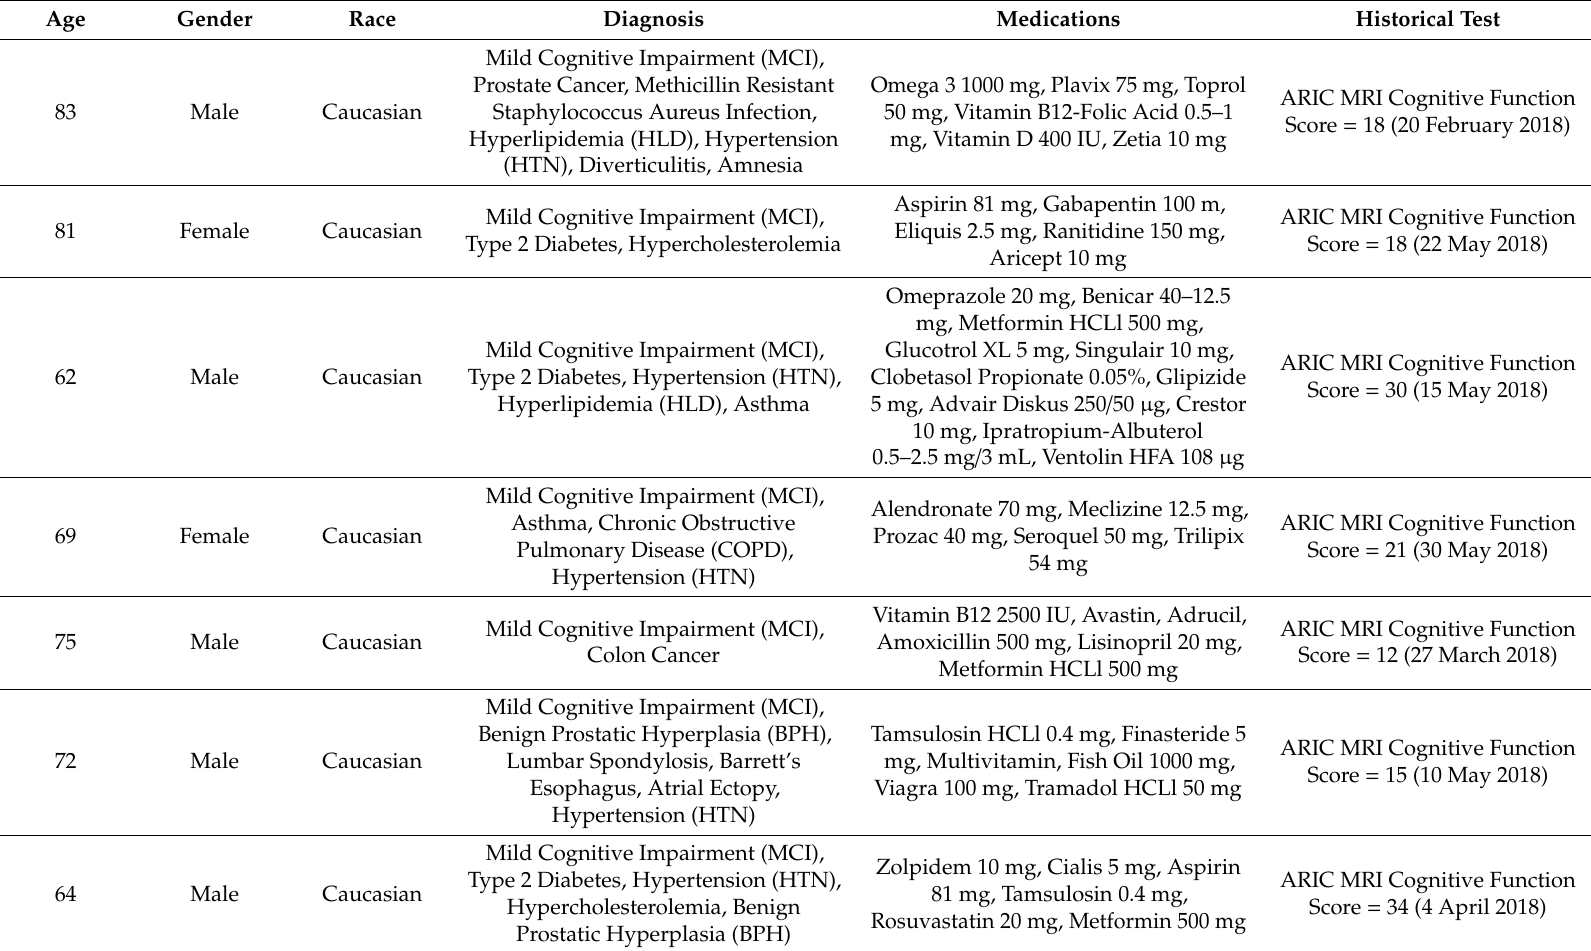
Table 3. Patients with MCI used in the study. ARIC MRI: Atherosclerosis Risk in Communities magnetic resonance imaging.